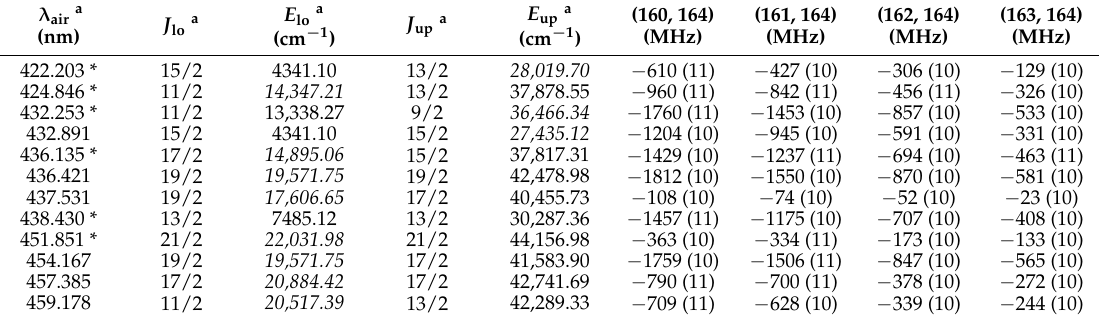
Table 4. Isotope shifts in Dy II, denoted by mass pairs: ( M, M’ ). The signs are determined by the convention that IS ≡ ν M (cid:48) − ν M where M (cid:48) > M . J lo , E lo and J up , E up are the total angular momentum and energy of the lower and upper levels of a transition,